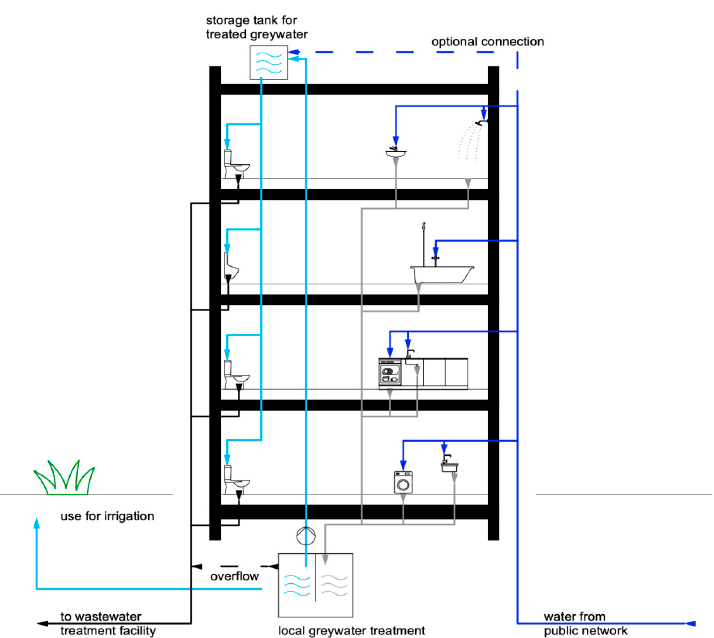
Figure 6. Diagram of the hydrologic cycle in a building with greywater treatment. Source: author .